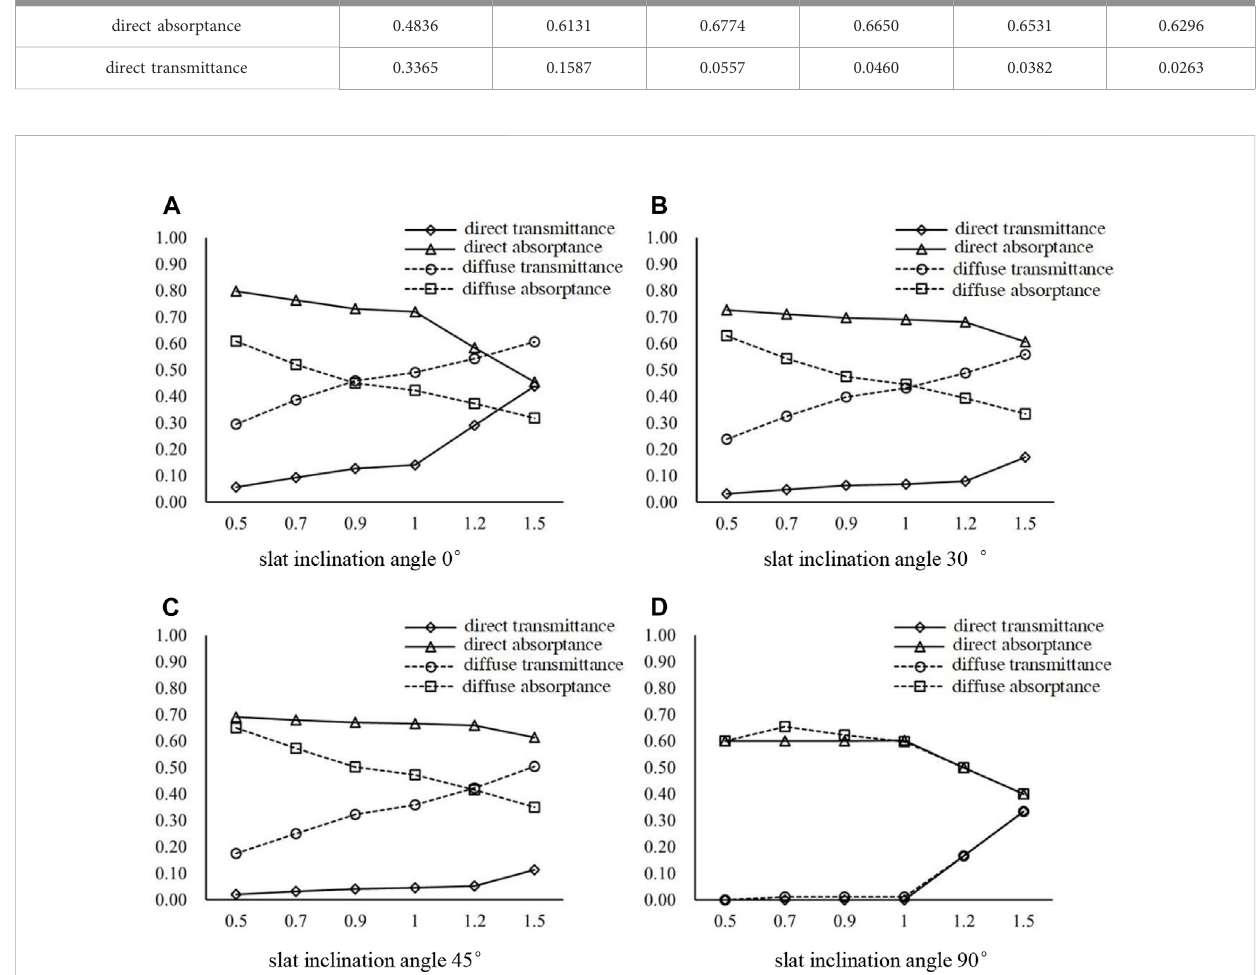
FIGURE 10 EffectofdifferentratiosofslatdistancetoslatwidthontheopticalperformanceofPCMblind. (A) slatinclinationangle0 ° (B) slatinclinationangle30 ° (C) slat inclination angle 45 ° (D) slat inclination angle 90 ° .